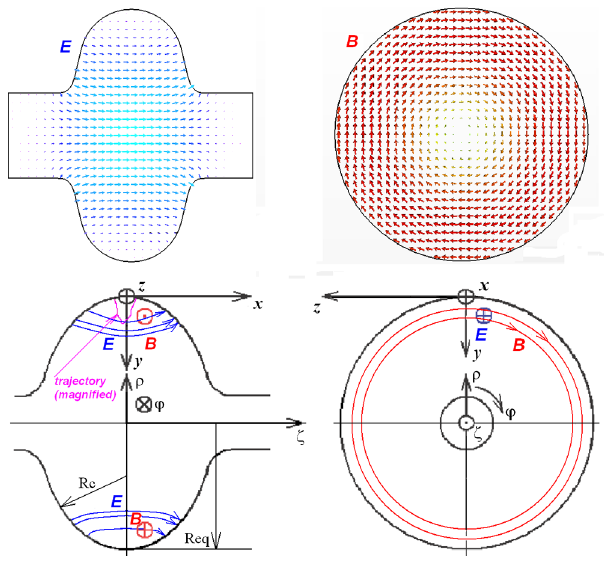
FIG. 2. Fields in an accelerating cavity as a whole (upper pictures) and the coordinate systems for calculation of multi- pacting near the equator.